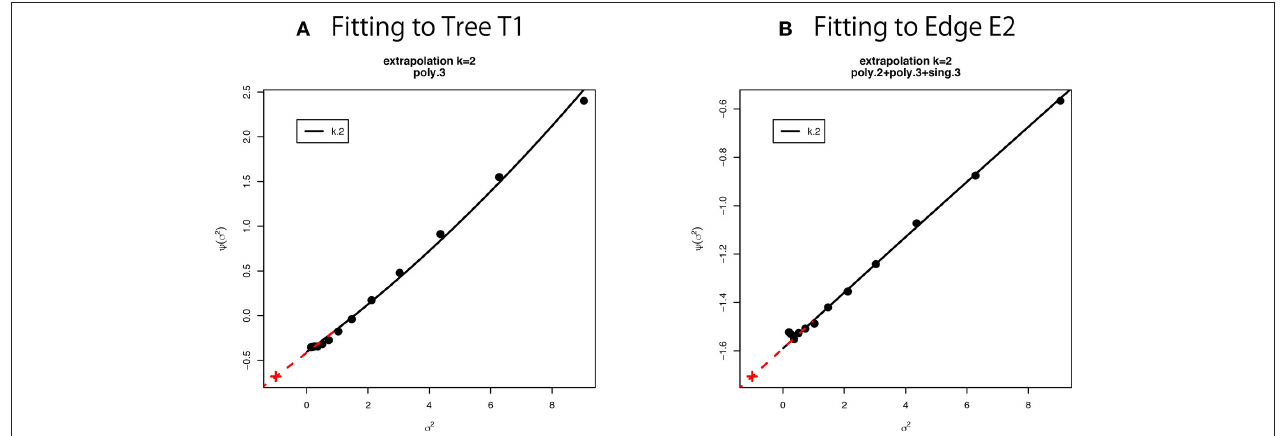
FIGURE 6 | Multiscale bootstrap for (A) tree T1 and (B) edge E2. ψ σ 2 ( R | y ) is computed by the non-parametric bootstrap probabilities for several σ 2 = n / n ′ values, then β 0 and β 1 are estimated as the intercept and the slope, respectively. See section 6.5 for details.